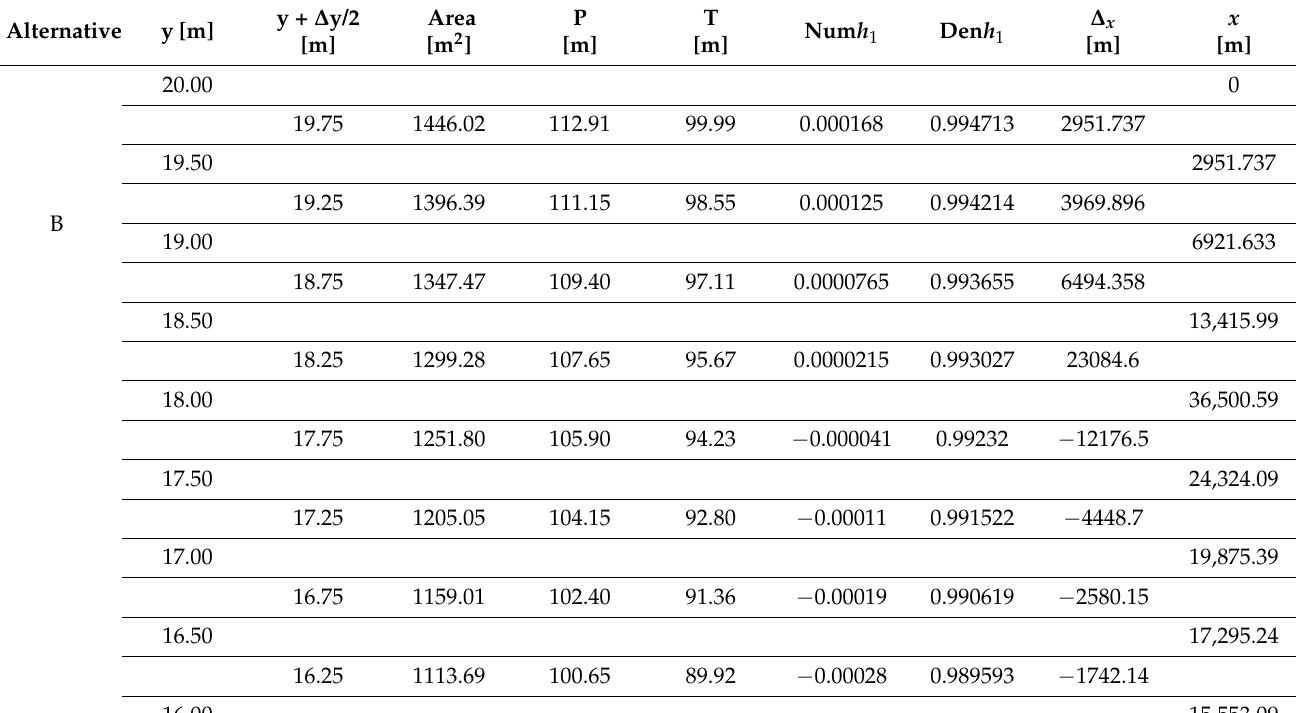
Table 7. Backwater Length of Alternative B.